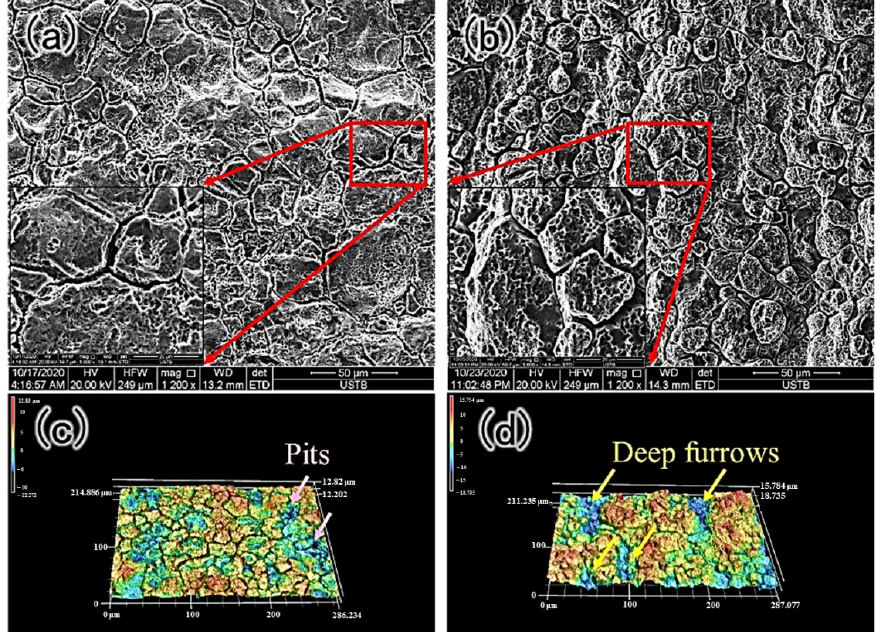
Figure 6. Corrosion morphology and the three-dimensional results. ( a , c ) correspond to the corrosion morphology of the external tube. ( b , d ) show the corrosion morphology of the internal tube.